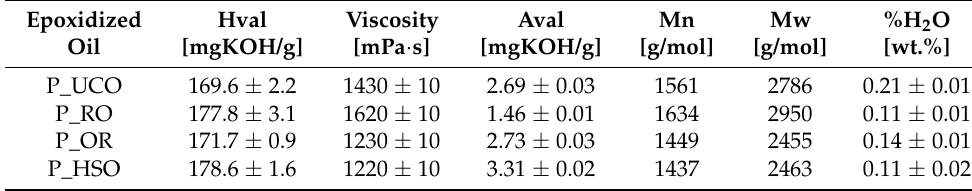
Table 5. Selected properties of the